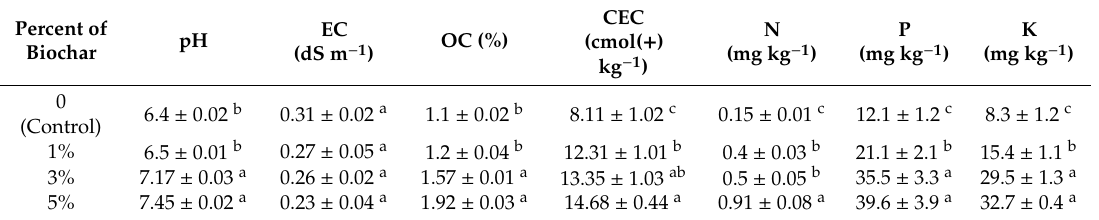
Table 4. Soil chemical properties (mean values ± SE) in presence of various percent of biochar. Percent of